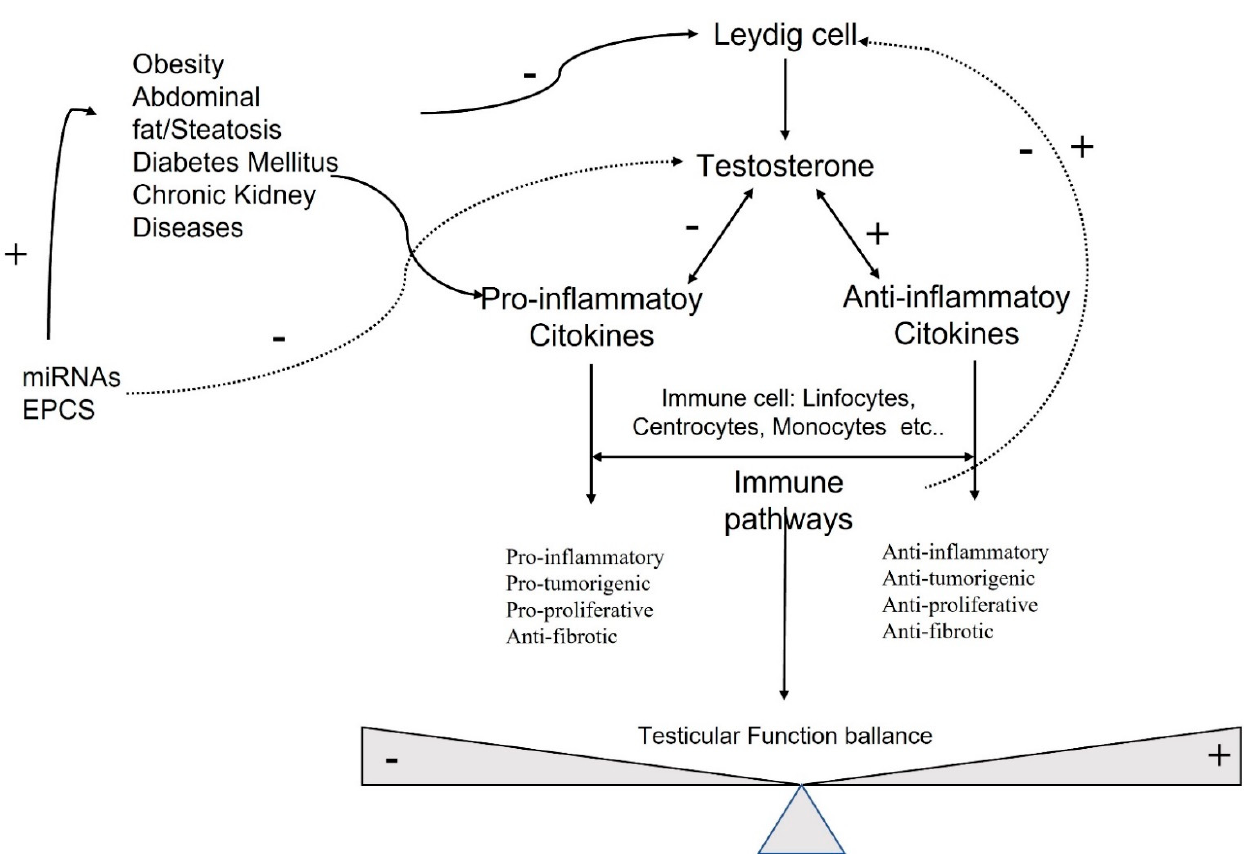
Figure 1. Molecular pathways involved in testicular function.